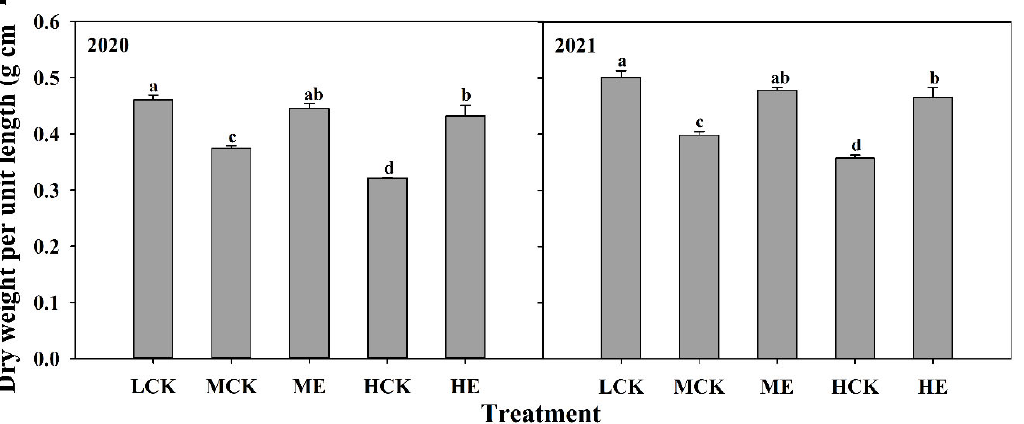
Figure 3. Effects of spraying ethephon on dry weight per unit length of the basal third internode. LCK, MCK, ME, HCK and HE were the treatments of low density control, medium density control, medium density sprayed with ethephon, high density control and high density sprayed with ethephon, respectively. Different lowercase letters in the figure indicated significant difference at 5%